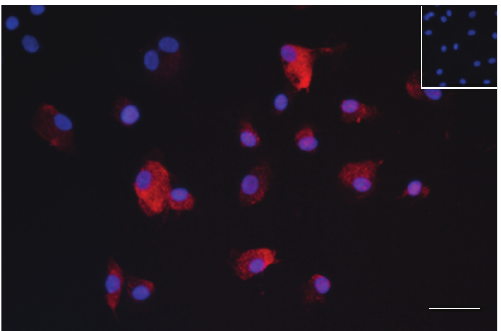
Figure 5: After 7 days of di ff erentiation, cells derived from the sphe- res also expressed β -III tubulin. Nuclei were counterstained with DAPI (blue). The inset is a negative control with nonimmunized IgG. Scale bar = 50 μ